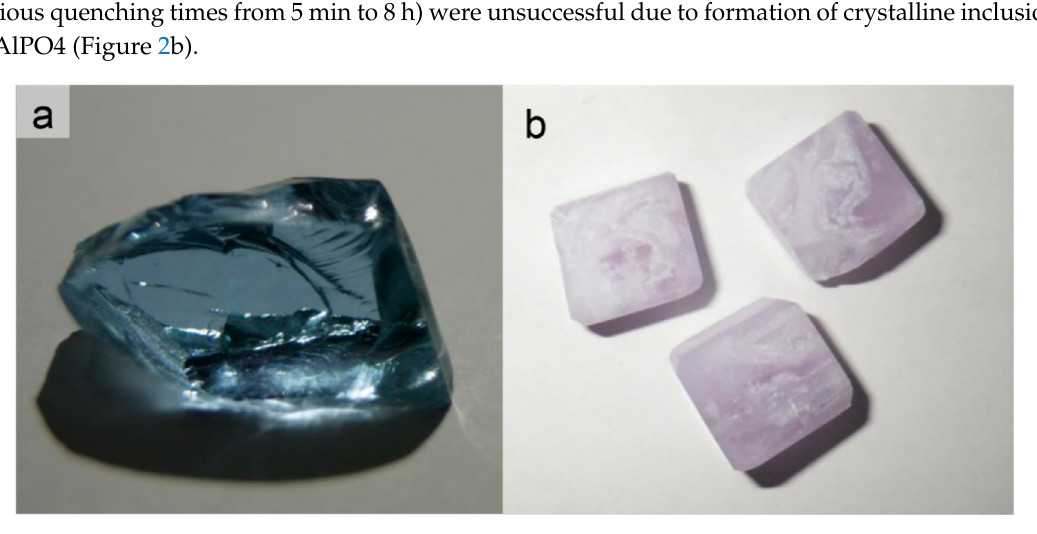
Figure 2. Fragments of homogeneous glass «Na ‐ Al ‐ P» doped with high level waste (HLW) simulant ( a ) and fragments of unacceptable partly crystallized glass with the same composition obtained in the unsuccessful one ‐ step process ( b ).